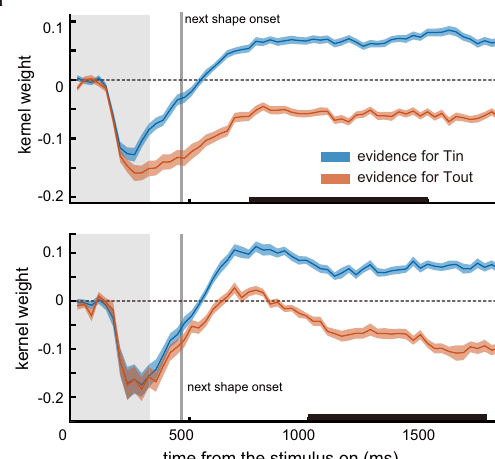
both, and the selectivities for SW in and SW out are not signi fi cantly different other thanthesign.Bluemarkers(monkeyM:42,monkeyH:19)indicatetheneuronsthat are selective to both, but the selectivity is signi fi cantly different. Red markers (monkey M: 13, monkey H:18) indicate the neurons only selective to SW in . Green markers(monkeyM:10,monkeyH:9)indicatetheneuronsonlyselectiveto SW out . The dashed line is the anti-diagonal, and the histogram shows the distribution of the difference between the neurons ’ selectivities for SW in and SW out in monkey M (blue) and H (yellow), whose means are not signi fi cantly different from 0 (monkey M: p =0.65,monkeyH: p =0.83,two-tailedttest).Themeanandthe p valueforthe combined monkeys ’ data are indicated in the